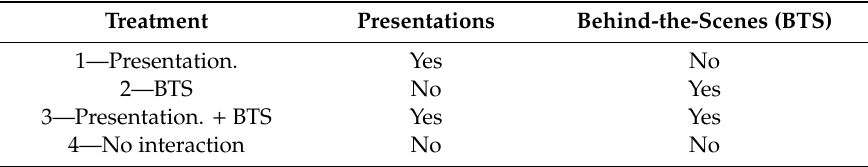
Table 1. Treatments imposed during the study period.